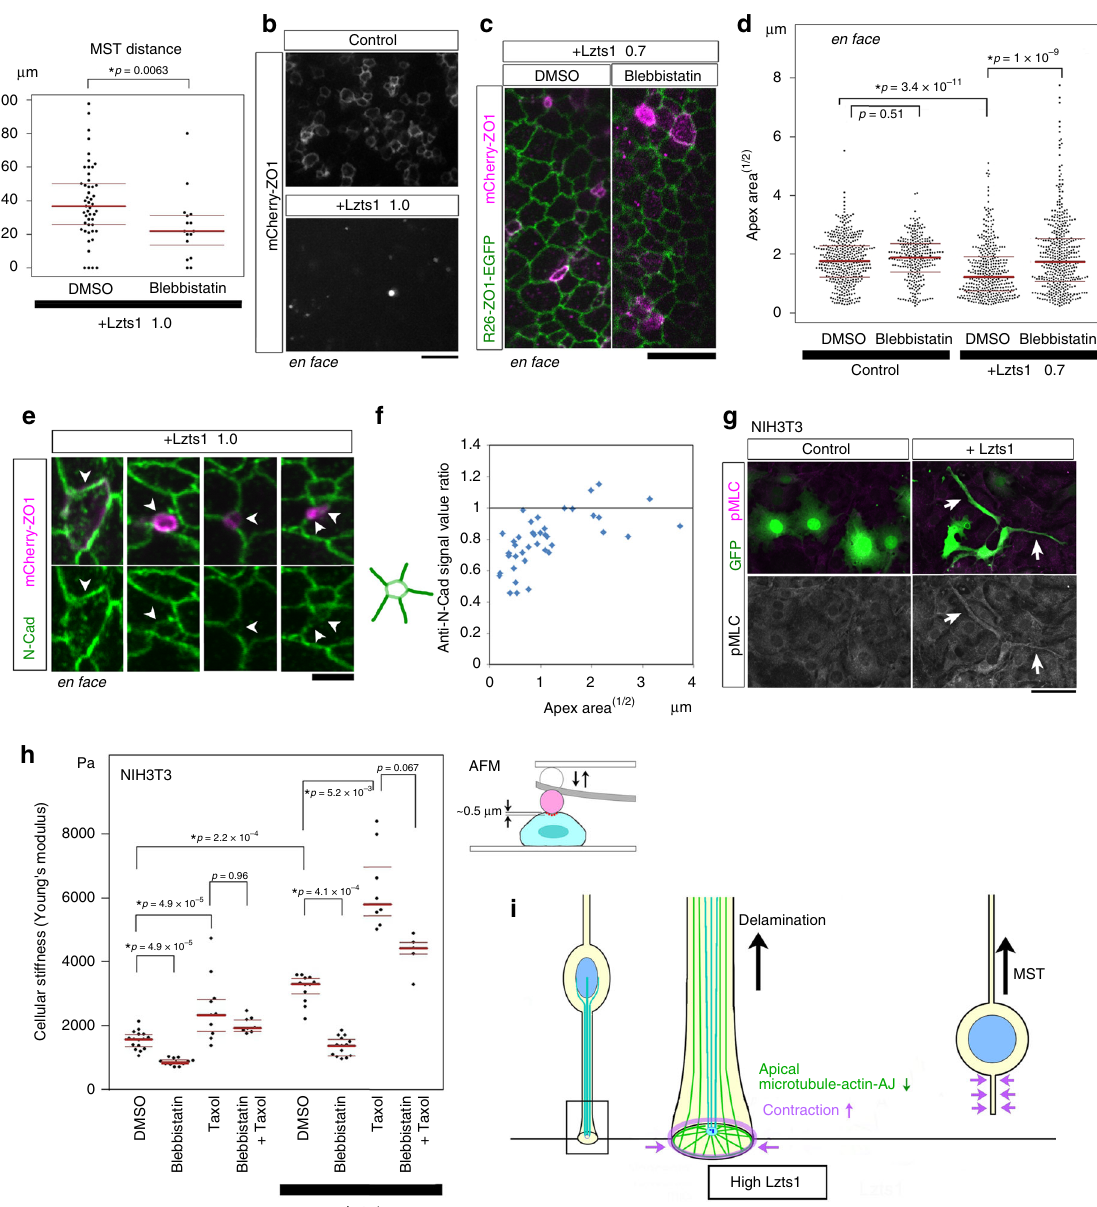
Fig. 7 Lzts1 induces MST and apical contraction with dwonregulation of N-cadherin. a The distance of the MST in the SVZ induced by Lzts1 overexpression was decreased by blebbistatin, suggesting that the Lzts1-induced MST was mediated by myosin II ( N = 49 and 16 cases, Brunner – Munzel test). b Lzts1 expression promotes the constriction of the apical endfoot. ZO1 – mCherry with or without Lzts1 (1.0 μ g μ l − 1 ) was expressed at E13 following in vivo electroporation, and after 1 day, en face observations of the apical surface were performed. c , d The myosin II inhibitor blebbistatin signi fi cantly decreased Lzts1-induced constriction of the apical endfoot. ZO1 – mCherry with or without Lzts1 (pCAG::Lzts1: 0.7 μ g μ l − 1 ) was electroporated into E13 R26-ZO1-EGFP mice, and after 1 day, blebbistatin or an equal concentration of DMSO was injected into the lateral ventricle for 30 min. En face observations of the apical surface are shown. d N = 380, 364, 378, and 433 cells from three embryos per experiment. Steel – Dwass test. e , f N-cadherin expression at AJs was decreased along with the contraction of the AJ rings in cells overexpressing Lzts1 (arrowheads). The signals for the anti-N- cadherin antibody at the Lzts1-expressing apical endfeet were compared to the signals at the neighboring cellular junctions. N = 40 cells from two embryos in f . g Anti-phospho-myosin light chain 2 (pMLC) staining of control or Lzts1-expressing mouse fi broblast NIH3T3 cells (arrows). h Exogenous Lzts1 expression makes NIH3T3 cells stiffer than control cells by activating the actomyosin system, and this activation occurs even in the cells with the taxol- induced stabilization of microtubules. AFM indentation measurements of cellular stiffness were performed at 2 h after cells were plated. N = 16, 12, 10, 8, 12, 14, 8, and 5 cells. Steel – Dwass test. i Lzts1 controls neuronal delamination (model). In differentiating cells, high levels of Lzts1 activate the Rho – ROCK-Myosin II pathway to enhance contraction and induce MST. Lzts1 concurrently perturbs the apical microtubule-actin-AJ complex at the apical endfoot by inhibiting microtubule polymerization to ensure the rapid delamination. Bars, 10 μ m in b , c , 3 μ m in e , and 50 μ m in g . Medians with Q1 and Q3